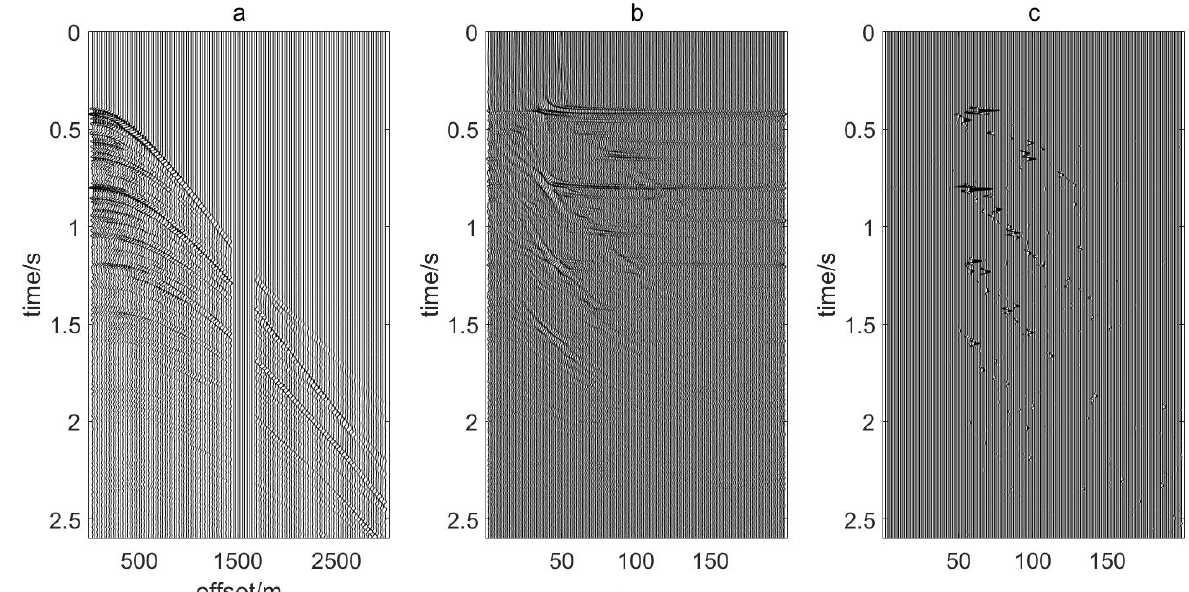
Figure 10. ( a ) CMP gather with empty regions; ( b ) CGRT Radon model result; ( c ) WRT Radon model result. Figure 12 shows the waveform of the original data and the inversion results at trace 10 and trace 64 at the reconstruction region. The black line represents the original data, while the red line and the blue line represent CGRT and WRT, respectively. Compared with the CGRT, for the field data, the WRT kept the waveform more accurate and preserved the AVO. The SNR of the reconstructed results for the CGRT and for the WRT are 4.32 dB and 9.71 dB,